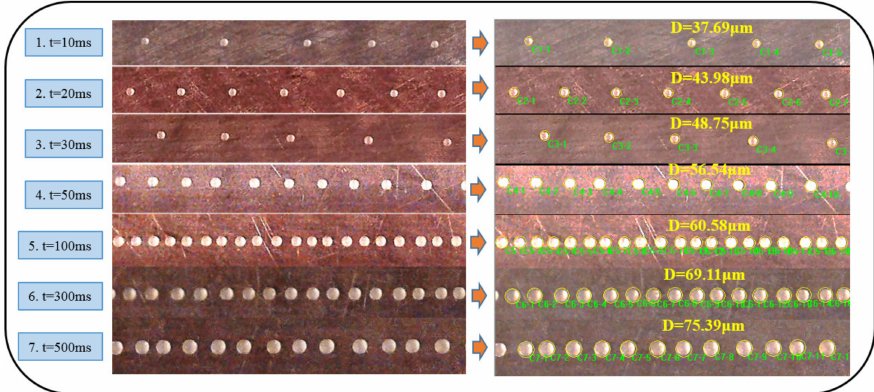
Figure 7. The experimental results of the droplet deposition at different pulse widths.